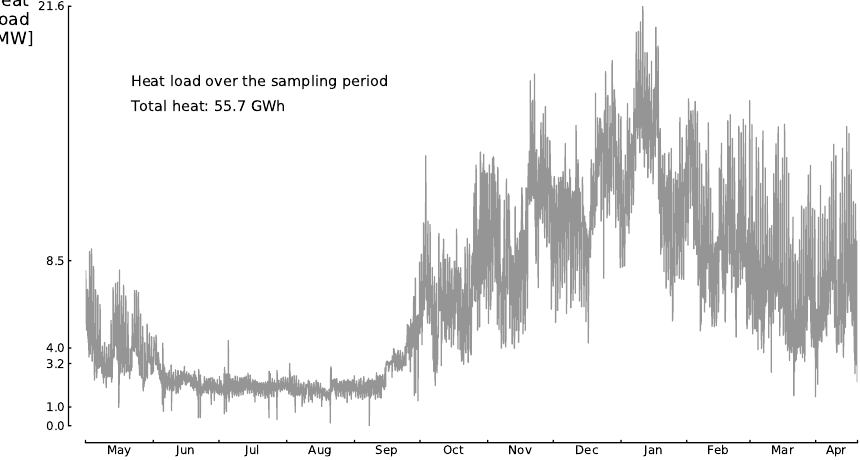
Figure 2. A drawing of the district heating plant on which the proposed methodology is applied. The DH plant comprises gas boilers with a total output thermal power of 22.5 MW, a 4 MW e CHP gas engine, a water tank storage of 400 m 3 , and two biomass boilers with output thermal powers of 3.2 MW and 5.3 MW.